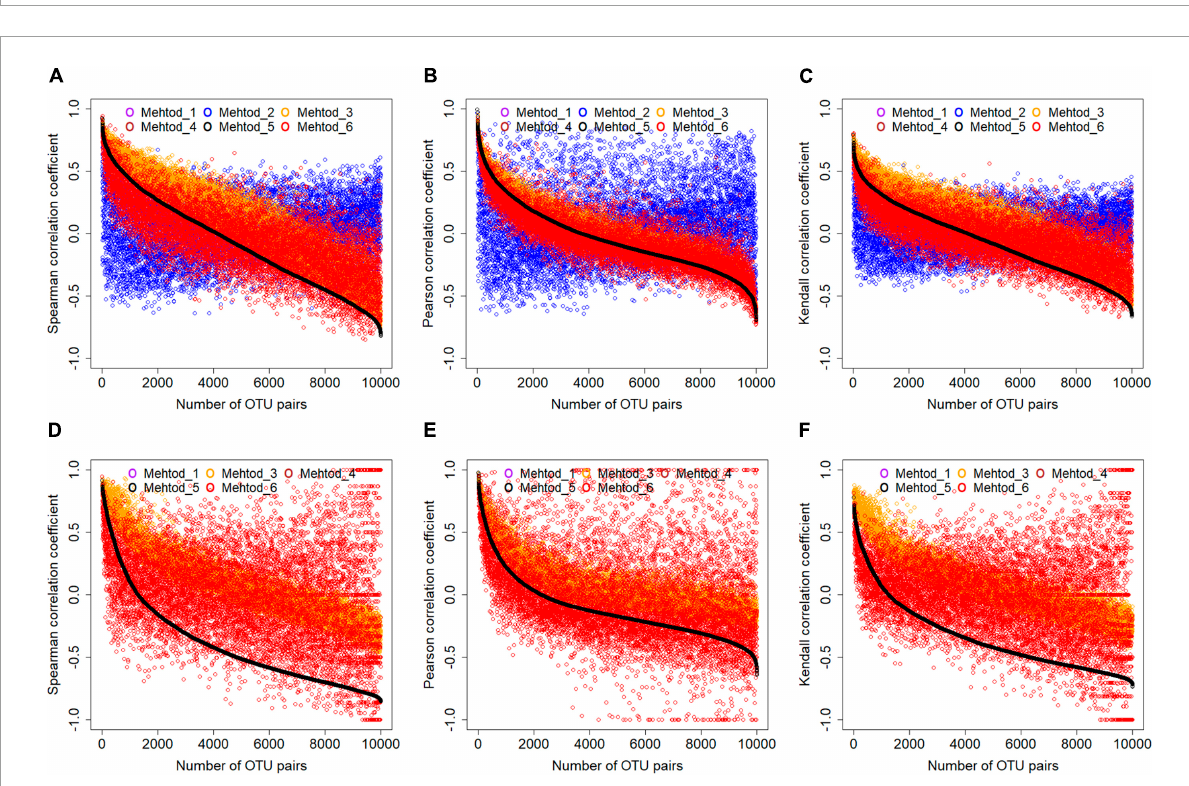
FIGURE4 The effects of data filtering methods on correlation coefficient calculation. Two types of datasets, including OTUs showing up in ≥ 60 samples (A–C) and OTUs showing up in ≥ 30 samples and ≤ 60 samples (D–F) were analyzed. Three different correlation calculation methods were evaluated, including the Spearman, Pearson, and Kendall. For better visualization, correlation coefficient values of 10,000 randomly selected OTU pairs were plotted. For the less frequent dataset (D–F) , nearest neighbor algorithm was not applicable.